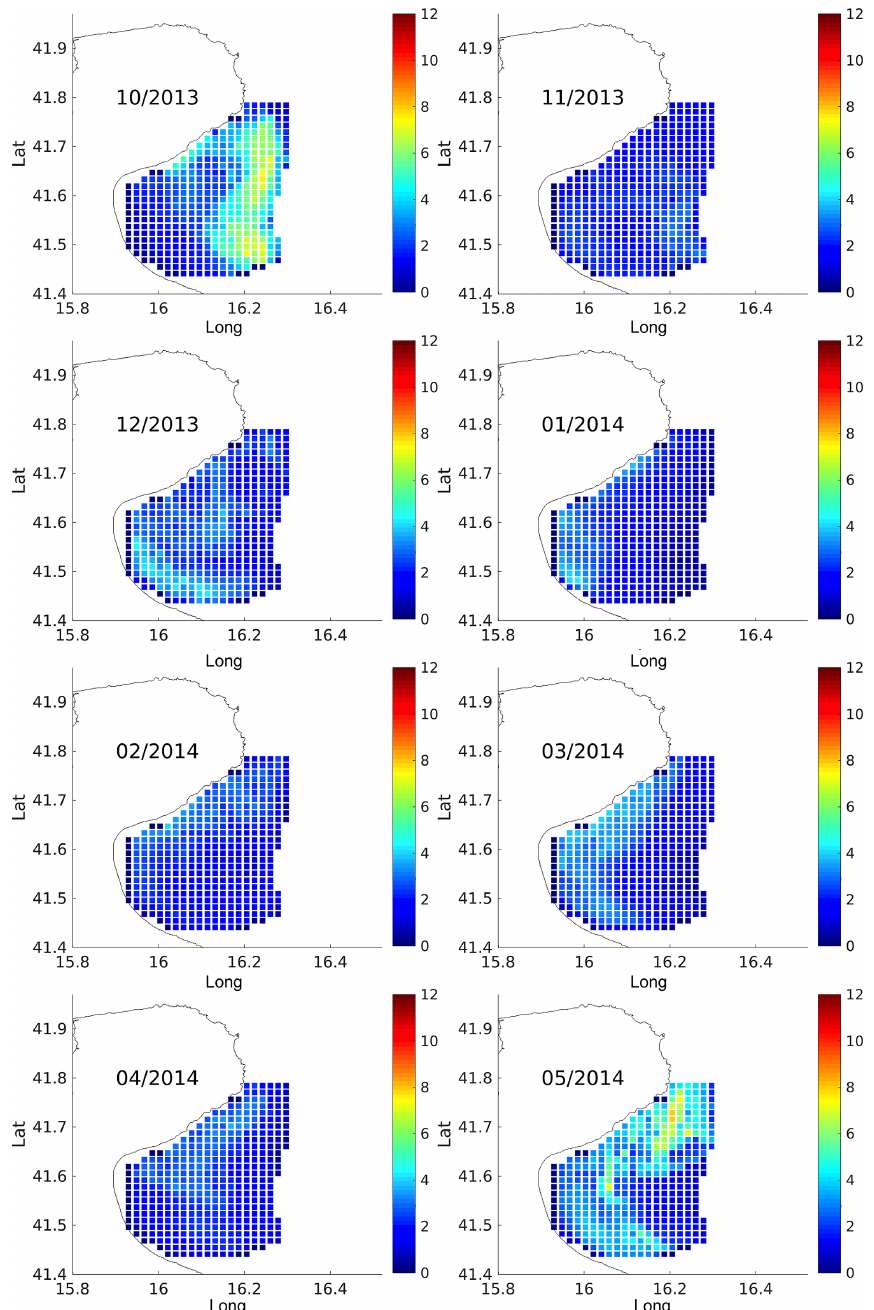
Figure 9. Monthly bootstrap estimates of average residence times (in days) of virtual particles advected in the HF radar velocity field and released within the boundaries of the Gulf of Manfredonia. The date ranges, number of releases, and total number of particles tracked per month are summarized in Table